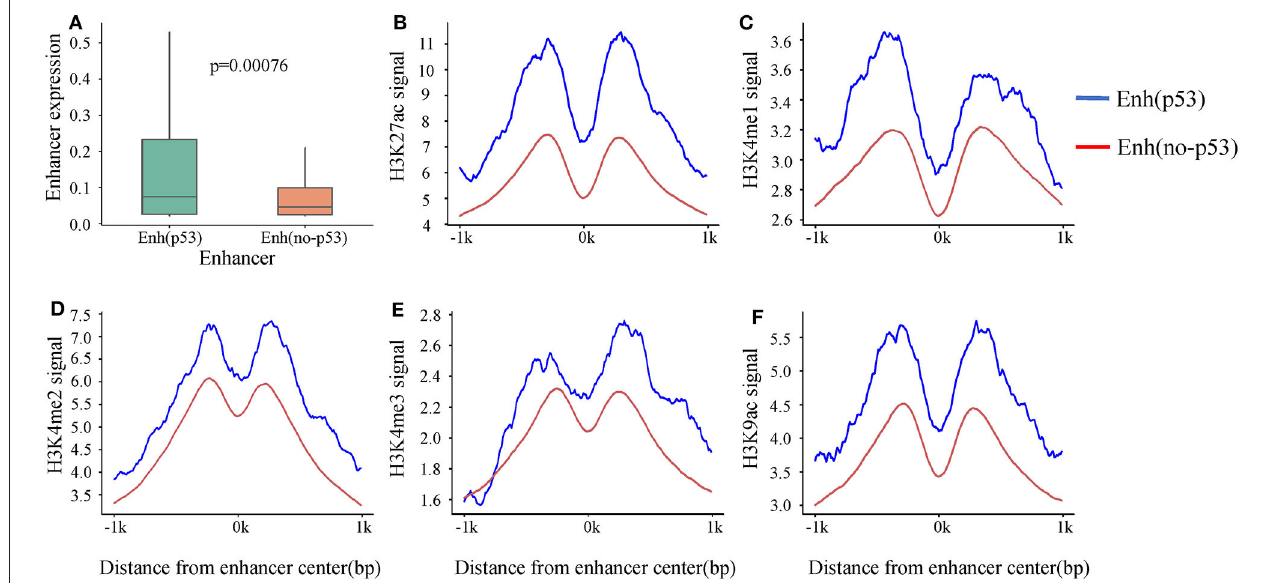
FIGURE 2 | The differences in expression and histone modification of the two types of enhancers. (A) The expression of the two types of enhancers. p -value is calculated by Wilcoxon test. (B–F) Different histone modification on the two types of enhancers. The blue line represents Enh p53 , and the red line marks Enh no